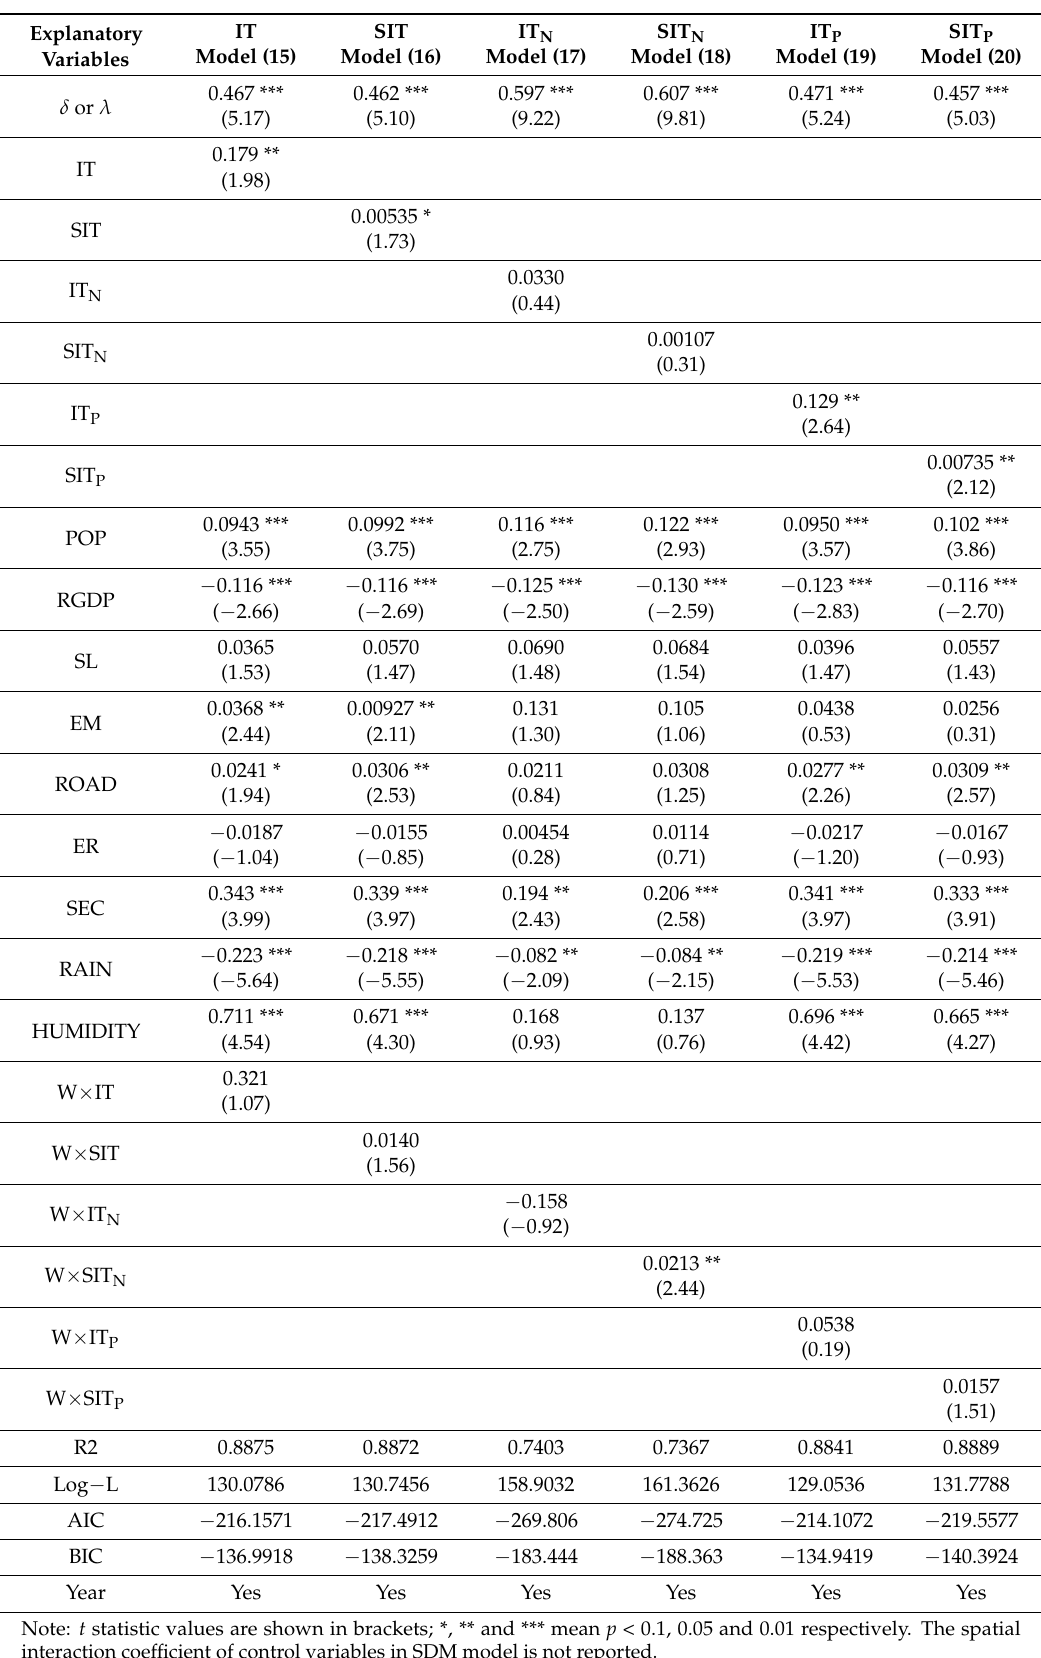
Table 10. Robust test results of spatial weight matrix based on geographic